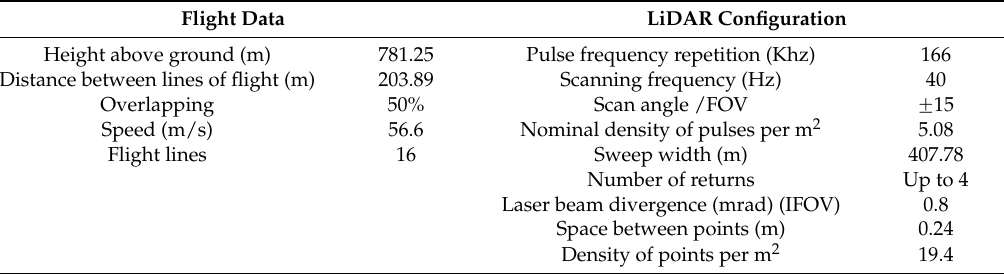
Table 3. Flight data and LiDAR